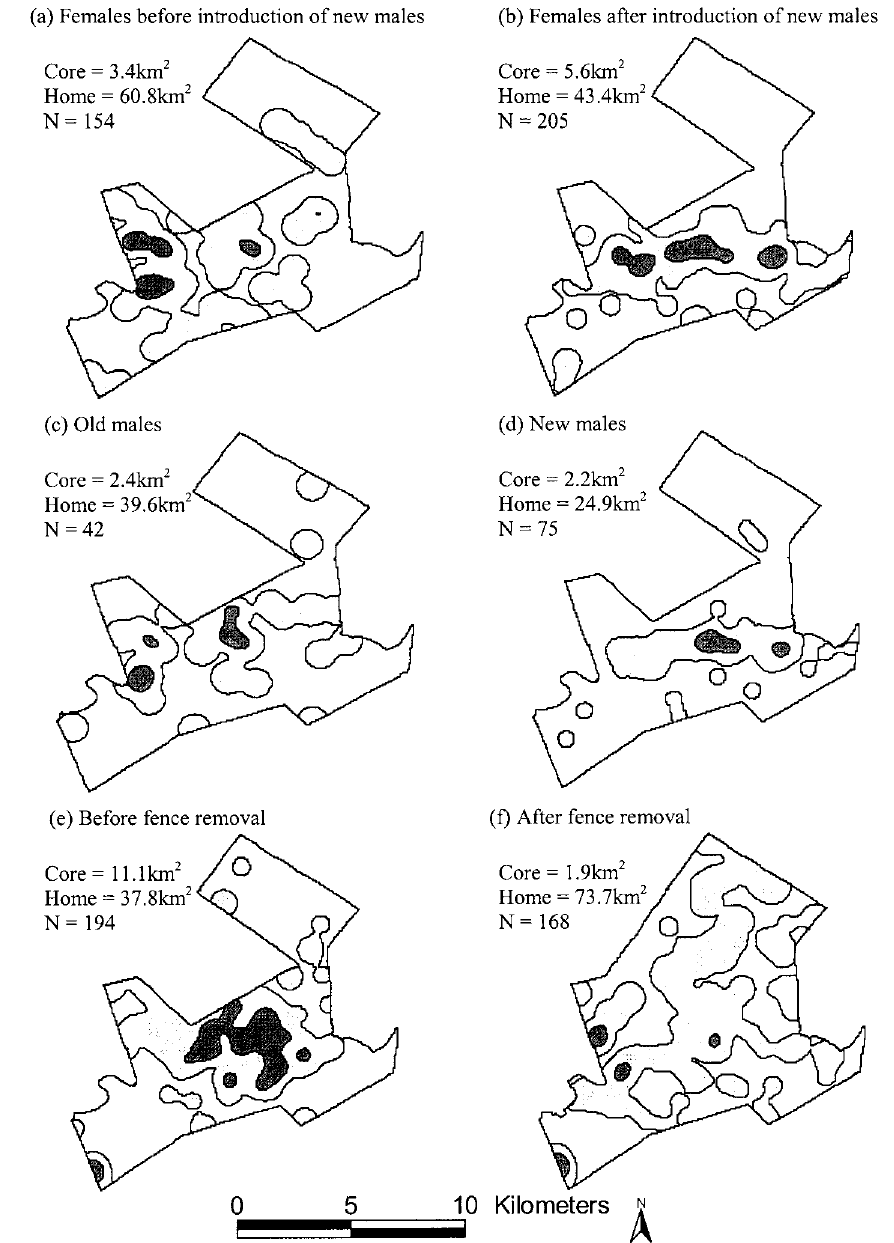
Fig. 3. The effect of two management interventions on the ranging behaviour of the Makalali lions between consecutive days. Core ranges (dark grey shading) are the 50 % kernel ranges while the home ranges (light grey shading) are the 95 % kernel ranges. (a) Female ranges before the introduction of the new males; (b) Female ranges after the introduction of the new males; (c) Old male ranges; d) New male ranges; (e) All lion ranges (males and females combined) before fence removal; (f) All lion ranges (males and females combined) after fence